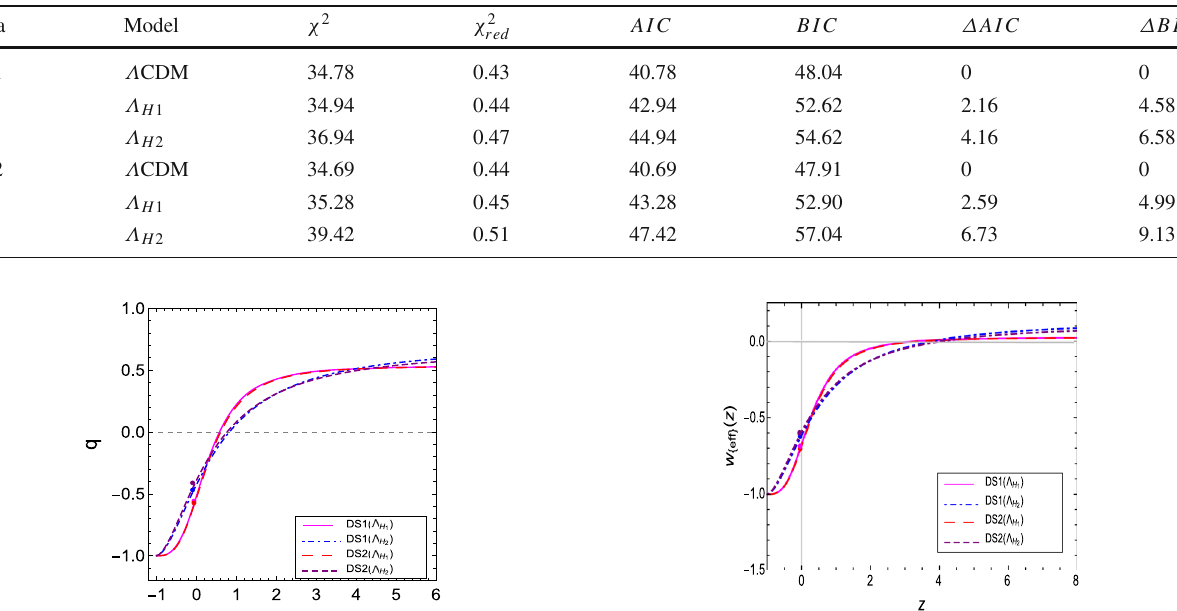
Table 3 Summary of χ 2 , χ 2 , AIC and BIC values and their differences from the reference model of Λ CDM obtained from joint analysis of red DS1 and DS2 data sets